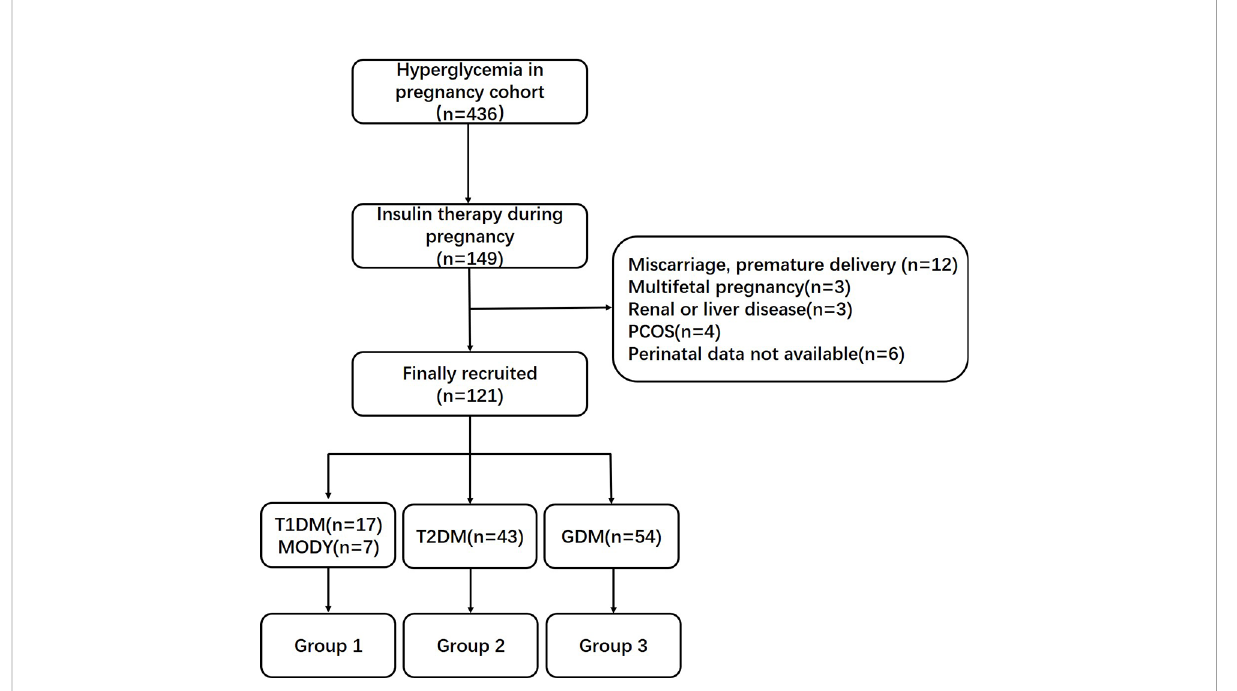
FIGURE 1 Flow chart of cohort selection. PCOS, polycystic ovarian syndrome; T1DM, type 1 diabetes mellitus; MODY, maturity onset diabetes of the young; T2DM, type 1 diabetes mellitus; GDM, gestational diabetes